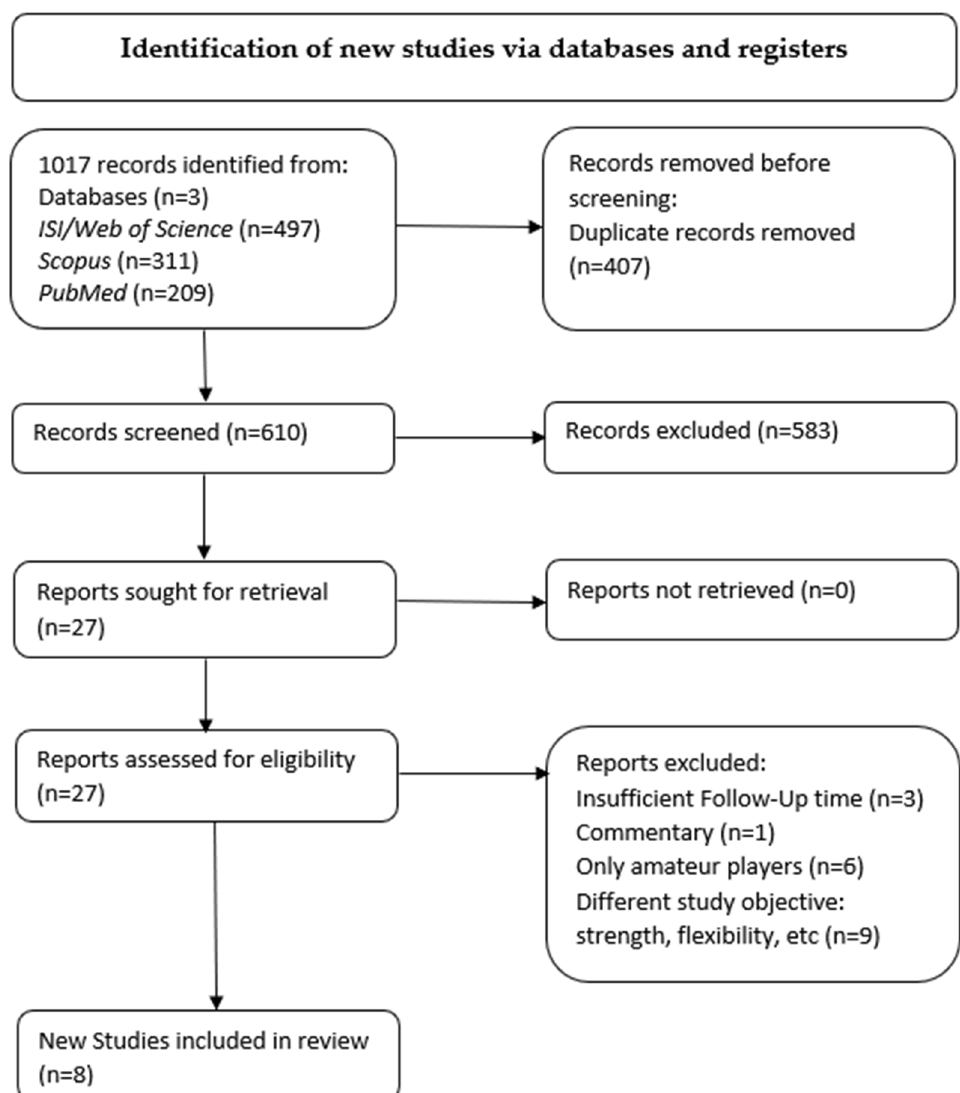
Figure 1. Preferred Reporting Items for Systematic Reviews and Meta-Analyses (PRISMA) flowchart representing the process for inclusion and exclusion of papers. For this study, 27 articles were assessed for eligibility after screening. Among these, 8 new studies were included in the anal- ysis.